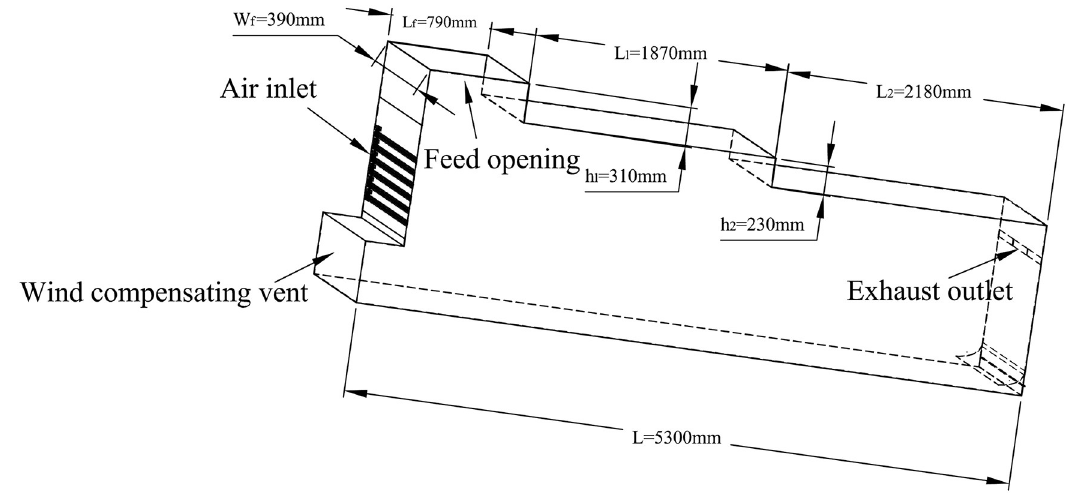
Fig 3. Box model of airflow forming machine.